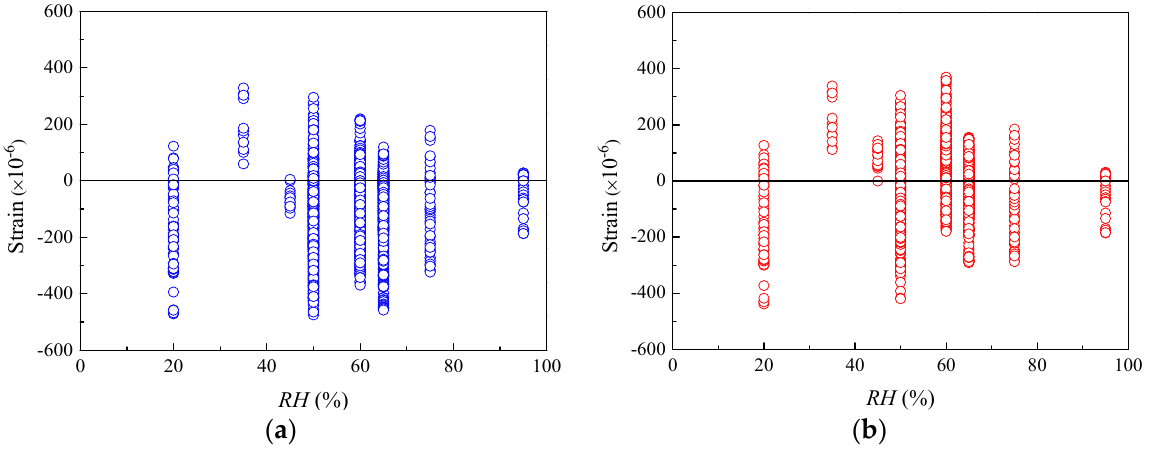
Figure 3. The residuals of shrinkage strain for CEB-FIP models versus RH. ( a ) Residuals for CEB-FIP 1990 model. ( b ) Residuals for CEB-FIP 2010 model.